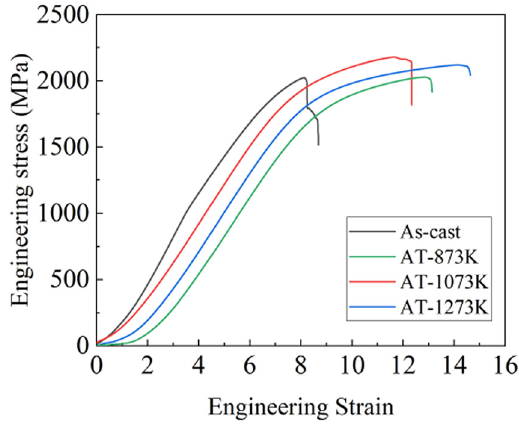
Figure 4: The strain – stress curves of as - cast and annealed FeCoCrNiMo alloys.